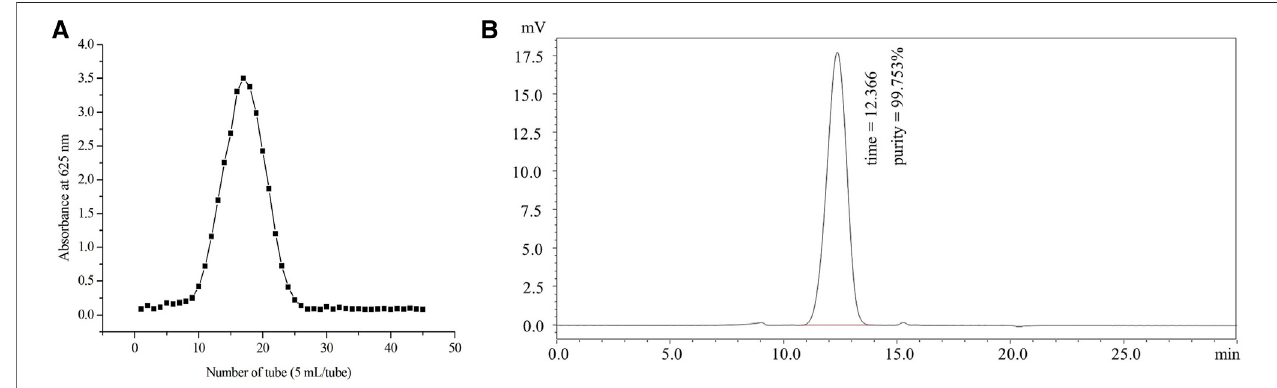
FIGURE 1 | Preparation and fractionation of BFO. (A) Elution curve of gel fi ltration chromatography on a Sephadex G75 column. (B) Molecular weight and homogeneity of BFO determined by HPGPC.